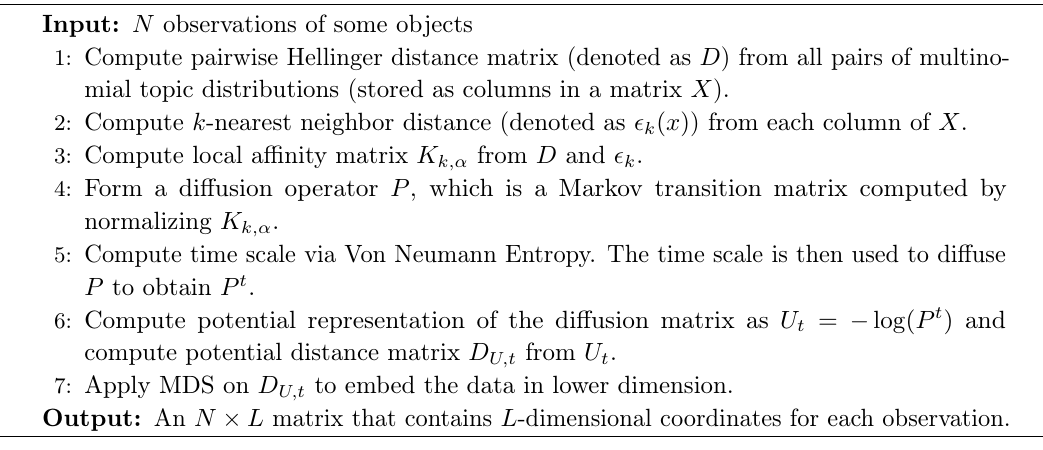
Algorithm D.1 PHATE with Hellinger